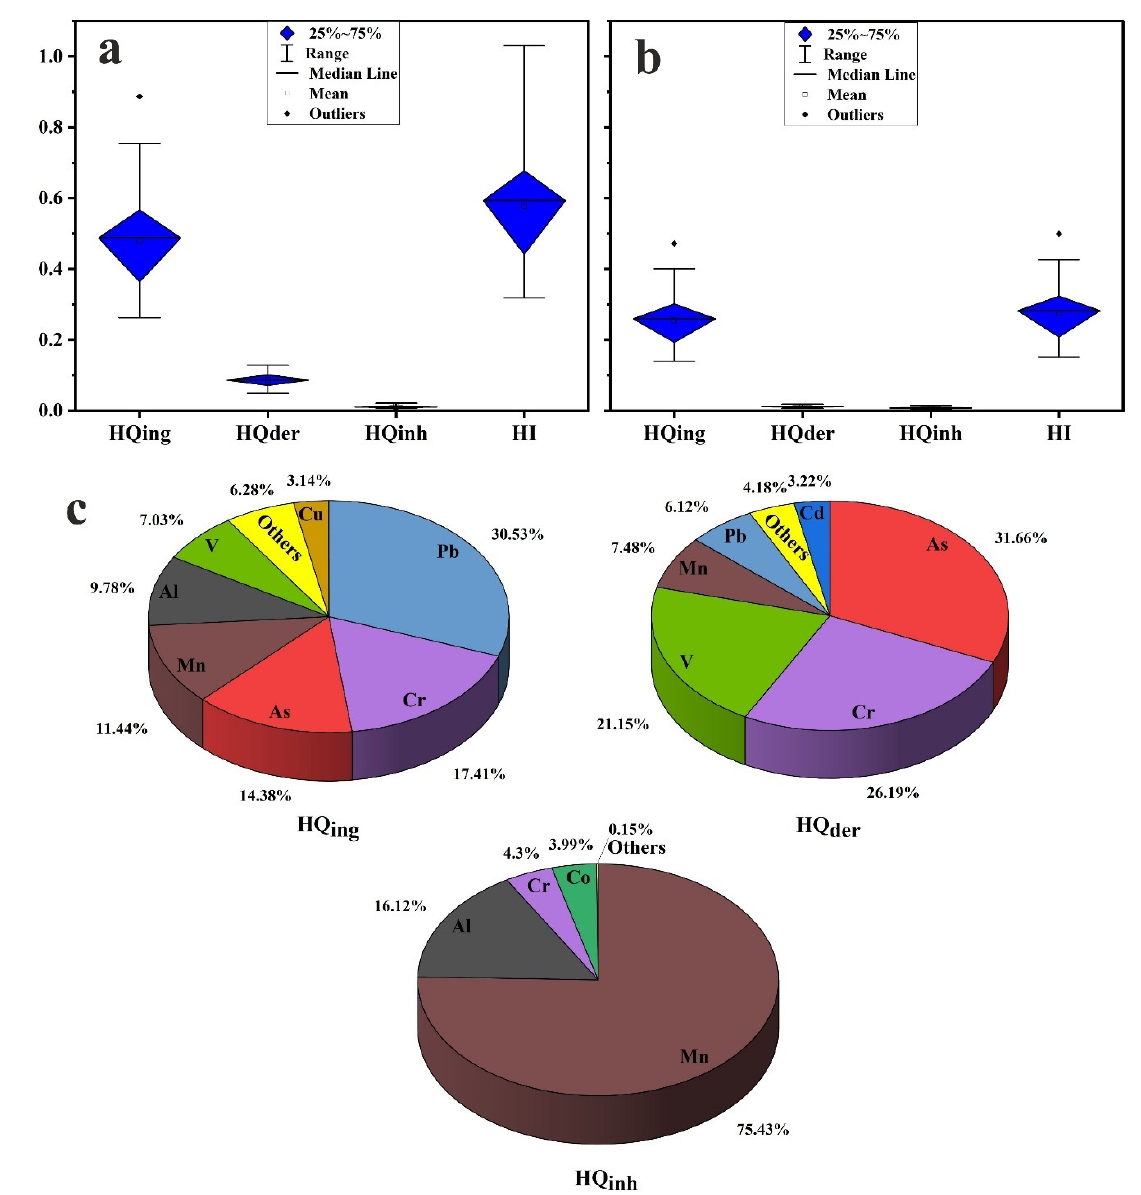
Figure 7. ( a ) Boxplots of noncancer risk for children; ( b ) for adults; ( c ) pie chart showing individual element contribution (%) for noncarcinogenic risk.